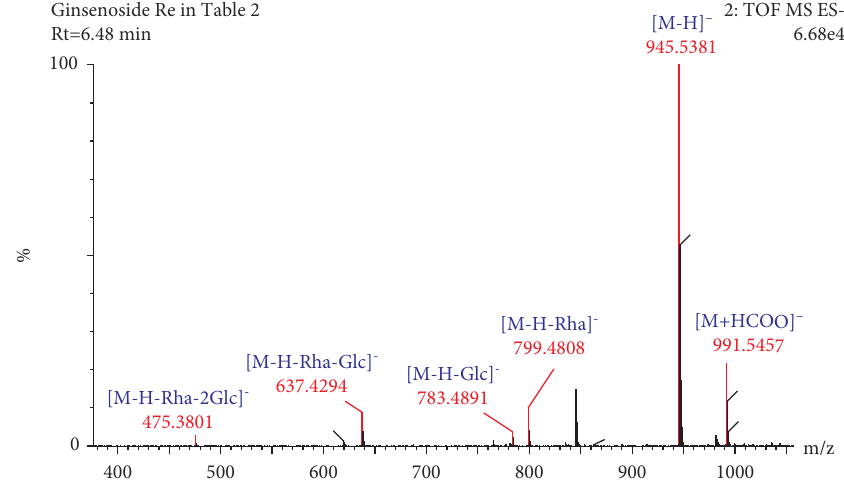
Figure 6: Secondary mass spectrogram of ginsenoside Re.